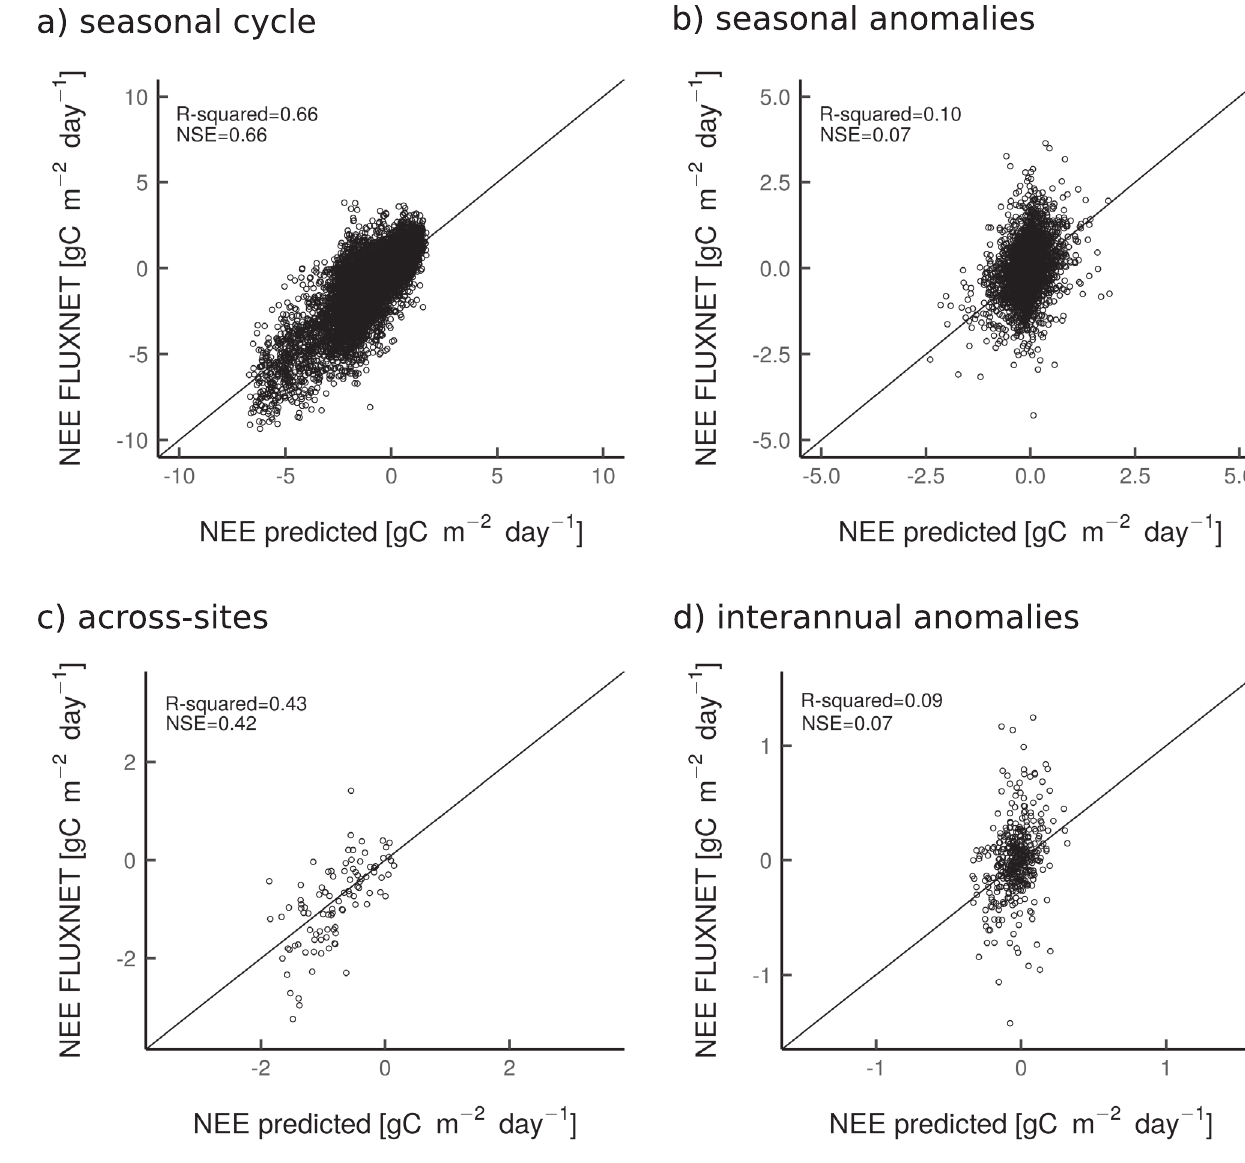
Fig 4. Scatterplots of observed data by eddy-covariance and the LSTM modeled fluxes for the seasonal cycle (Fig 4a), seasonal anomalies (Fig 4b), across- site variability (Fig 4c), and interannual anomalies (Fig 4d). The modeled estimates are derived from the mean ensemble of the 50 model runs.